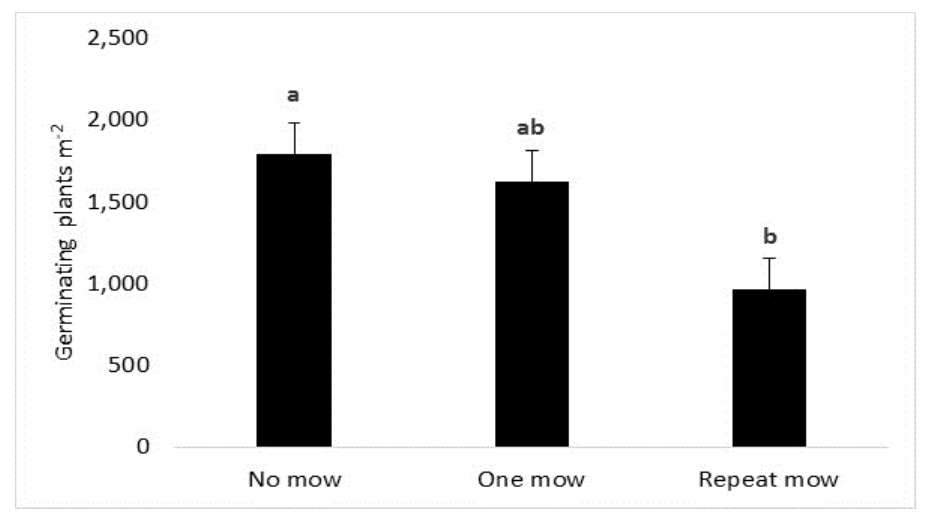
Figure 3. Mean (± pooled SE) number of emerging barley grass seedlings∙m −2 in response to the mowing of a barley grass infested legume crop after 12 months (2016). Bars with the same letter are not significantly different ( p < 0.05) after the Scheffe correction for type I error.